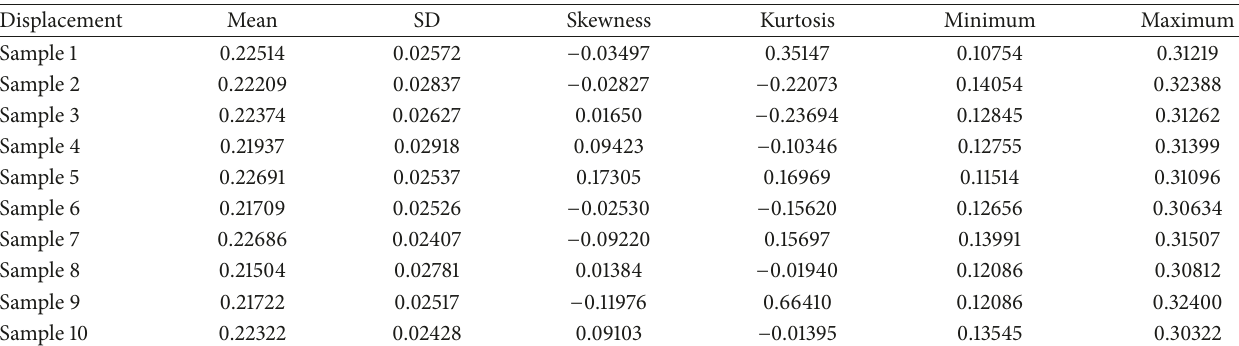
Table 12: Statistics of 10 samples parameters of the single low tower top node 874# Ux displacement time history under wind field 2